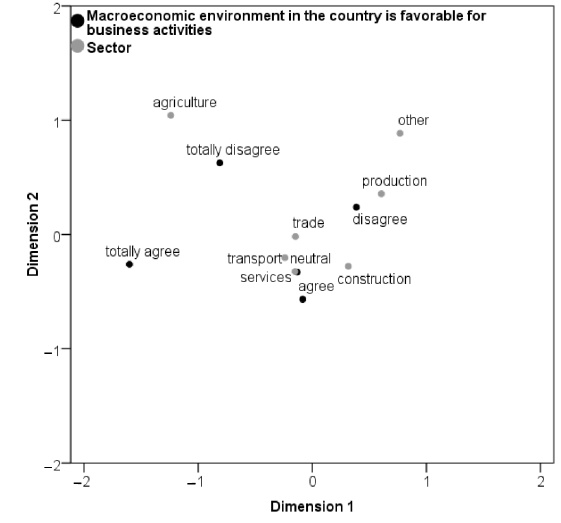
Figure 5. Correspondence analysis/the Slovak Republic